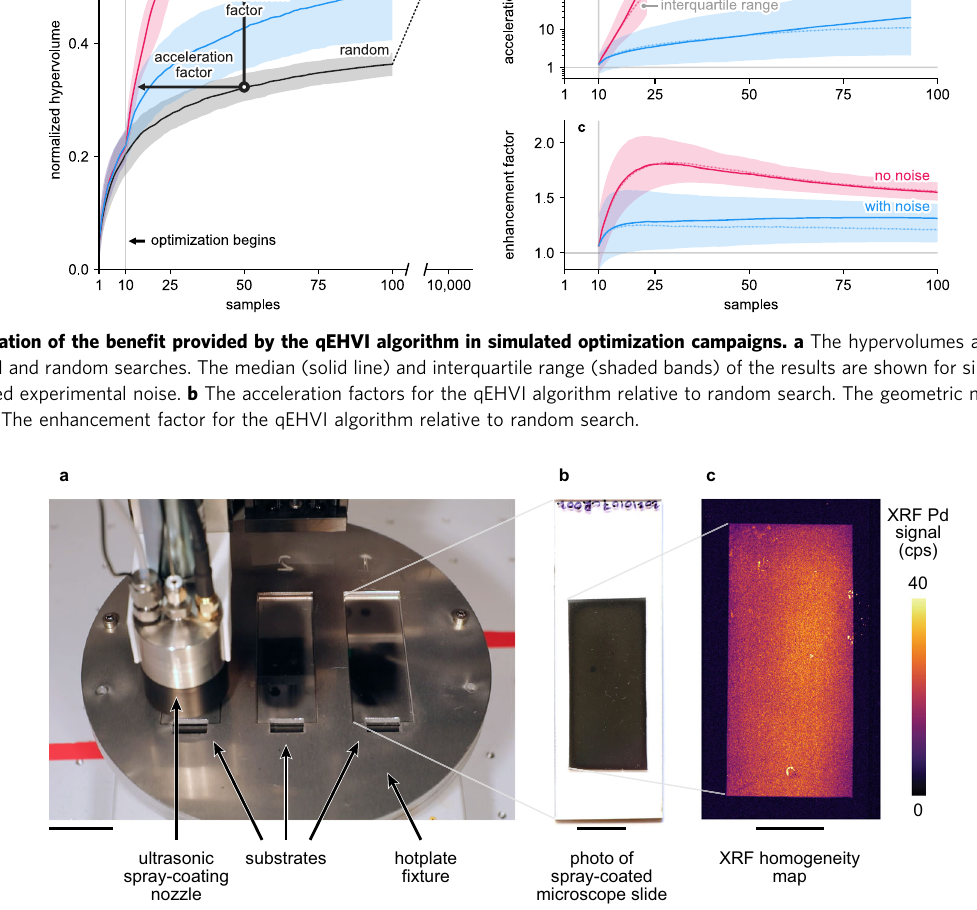
Fig. 5 Low-temperature spray combustion synthesis of homogeneous palladium fi lms over large areas. a Spray coating apparatus. An ultrasonic nozzle attached to an overhead XYZ stage (not visible) is used to spray palladium combustion synthesis precursors onto glass substrates placed on a hot plate with an aluminum fi xture. The precursors decompose to yield palladium fi lms. Scale bar is 3 cm. b Photograph of a typical resulting fi lm on a 3 ″ × 1 ″ glass substrate. Sharp edges were produced by masking the substrate using Kapton tape. c XRF map of the sample pictured in b . To aid visualization, the photograph in panel a has been fl ipped horizontally. Scale bars in b , c are 1